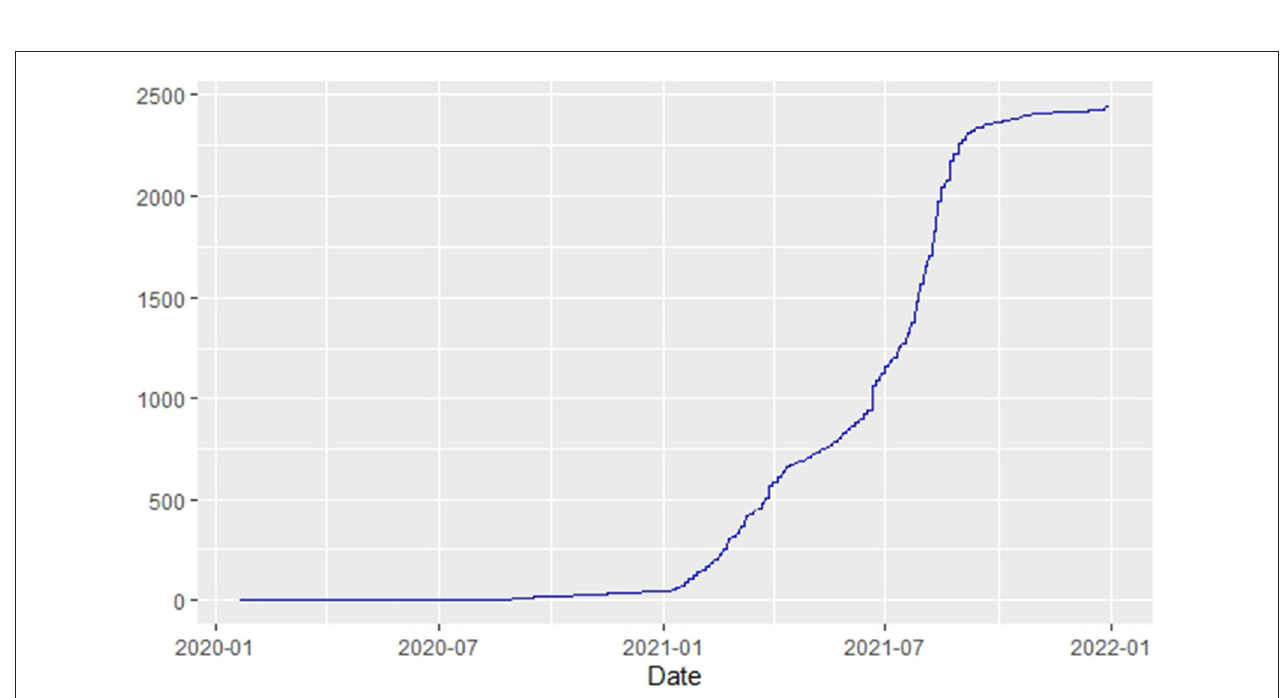
FIGURE 12 | Botswana